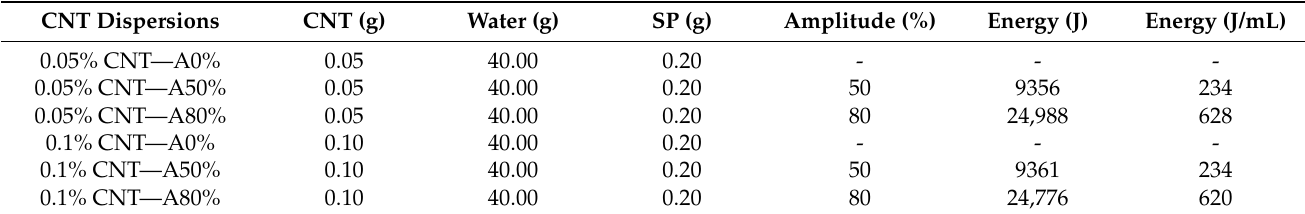
Table 3. Composition of CNT aqueous